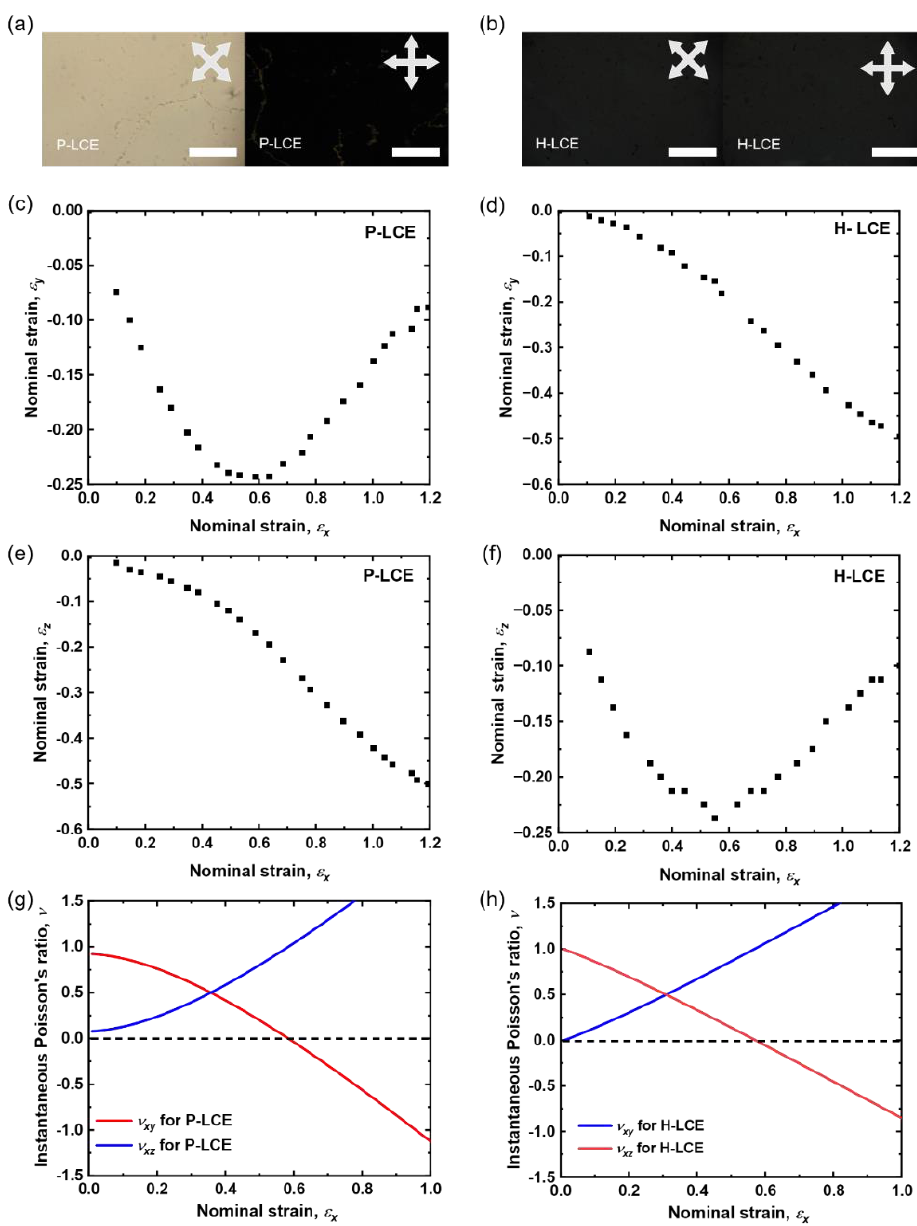
Figure 3. The POM images for ( a ) P-LCE and ( b ) H-LCE. The scale bar is 20 µ m and the white arrows indicate the crossed polarizers. The ε x – ε y strains measured for ( c ) P-LCE and ( d ) H-LCE, the ε x – ε z strains measured for ( e ) P-LCE and ( f ) H-LCE and instantaneous Poisson’s ratio, ν xy and ν xz measured for ( g ) P-LCE and ( h ) H-LCE.